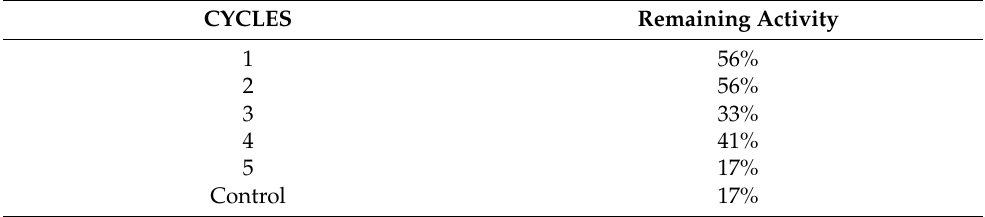
Table 7. Trypsin activity after successive synthesis cycles and elution using Tween 20. The activity was measured after 2 h at 405 nm.